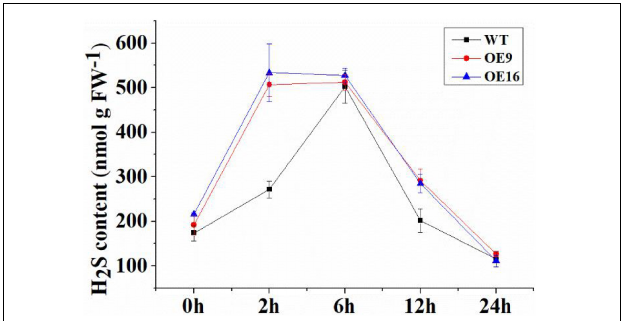
FIGURE 10 | The H 2 S contents of the wild-type (WT) and transgenic plants on cold stress for 0, 2, 6, 12, and 24 h. OE: the CaALAD -overexpressing (OE) lines. The error bars are the standard errors for three independent